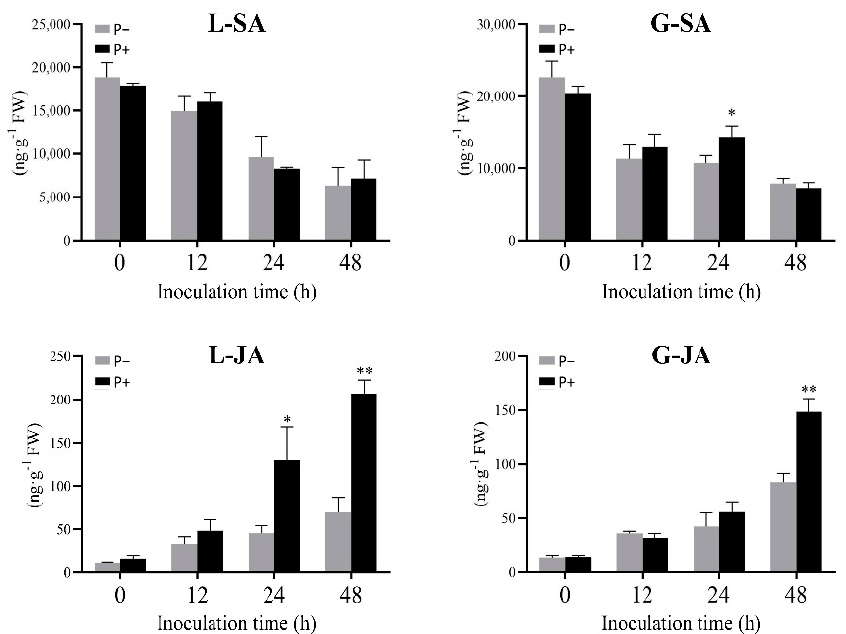
Figure 2. Changes in SA and JA contents in the G and L varieties treated with PQQ and ddH 2 O after inoculation. Asterisks indicate significant differences among different treatments (* p < 0.05, ** p < 0.01).